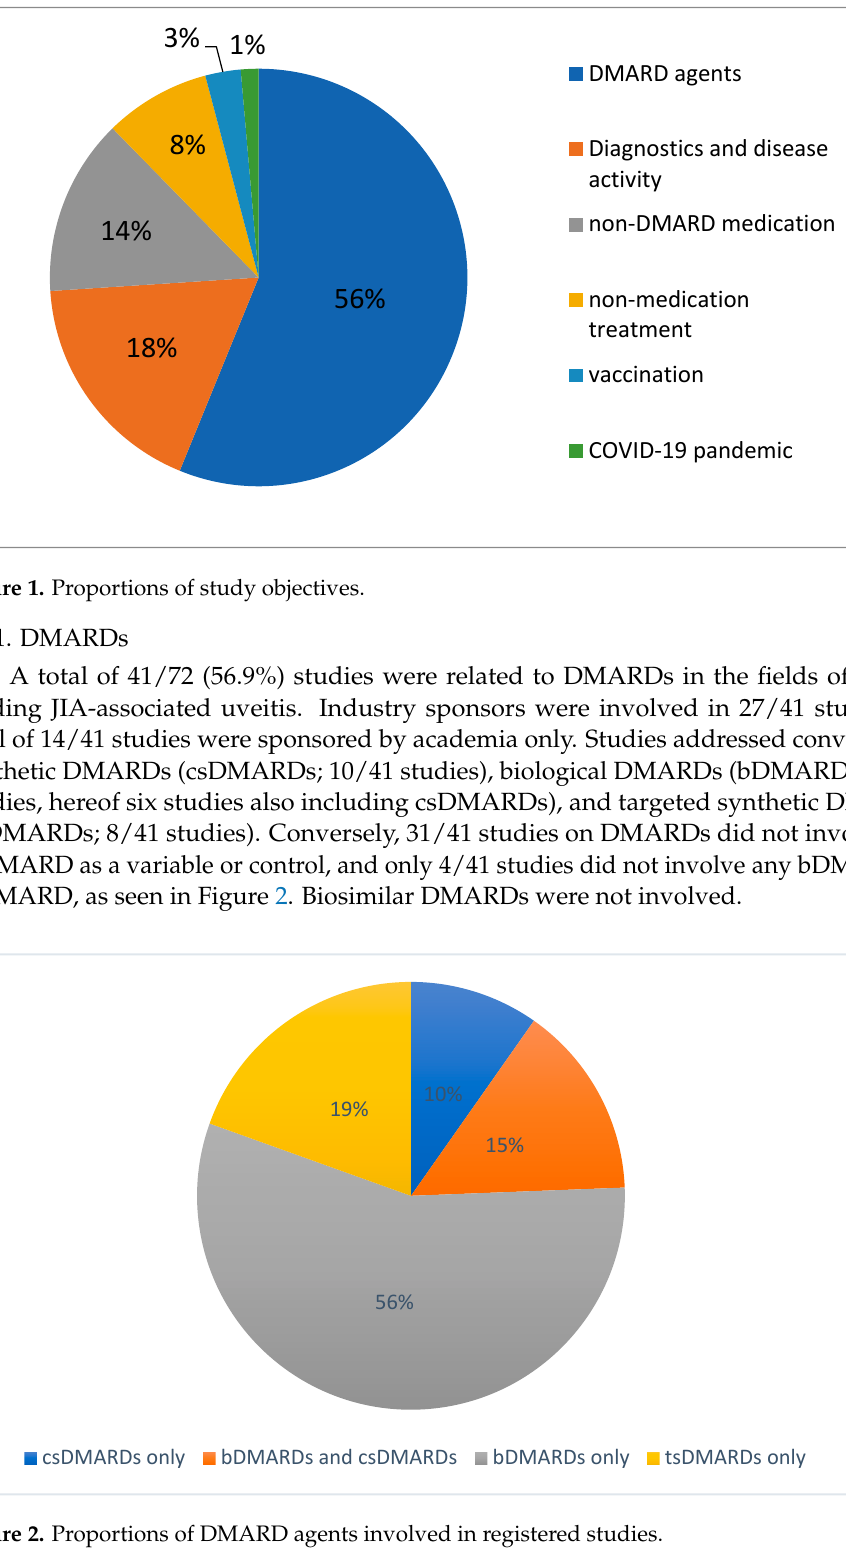
Figure 3. Number of studies concerning bDMARDs and tsDMARDs sorted for biological targets (interventional and observational studies, partly multiple agents involved per study). IL—interleu- kine, JAK—janus kinase, TNF—tumor necrosis factor. The enrollment of observational studies was median 833, with a minimum of 10 and a maximum of 9000. For clinical phases and planned enrollments in the interventional studies on DMARDs, see Tables 1 and 2. All industry-sponsored studies were located in multiple countries, whereas only two of the academia-sponsored studies had locations in more than one country (the USA, UK, and several EU countries, respectively).